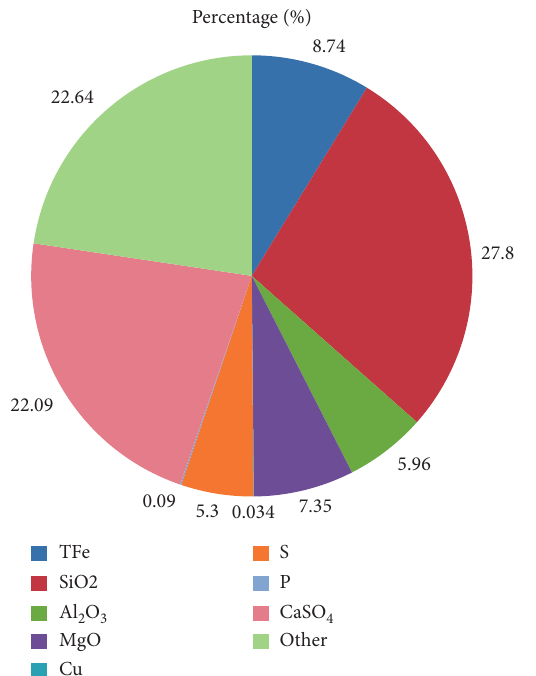
Figure 2: Chemical composition of